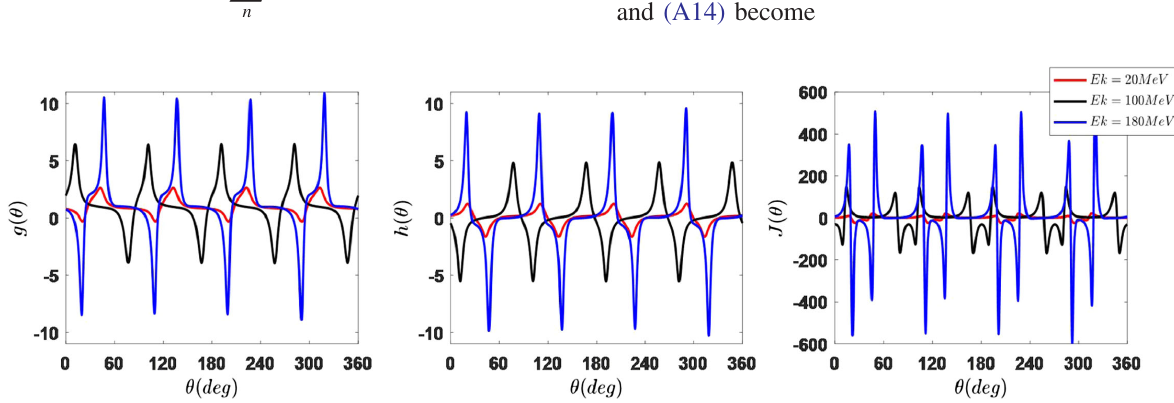
FIG. 10. Coefficients g ð θ Þ , h ð θ Þ , and J ð θ Þ for different energy